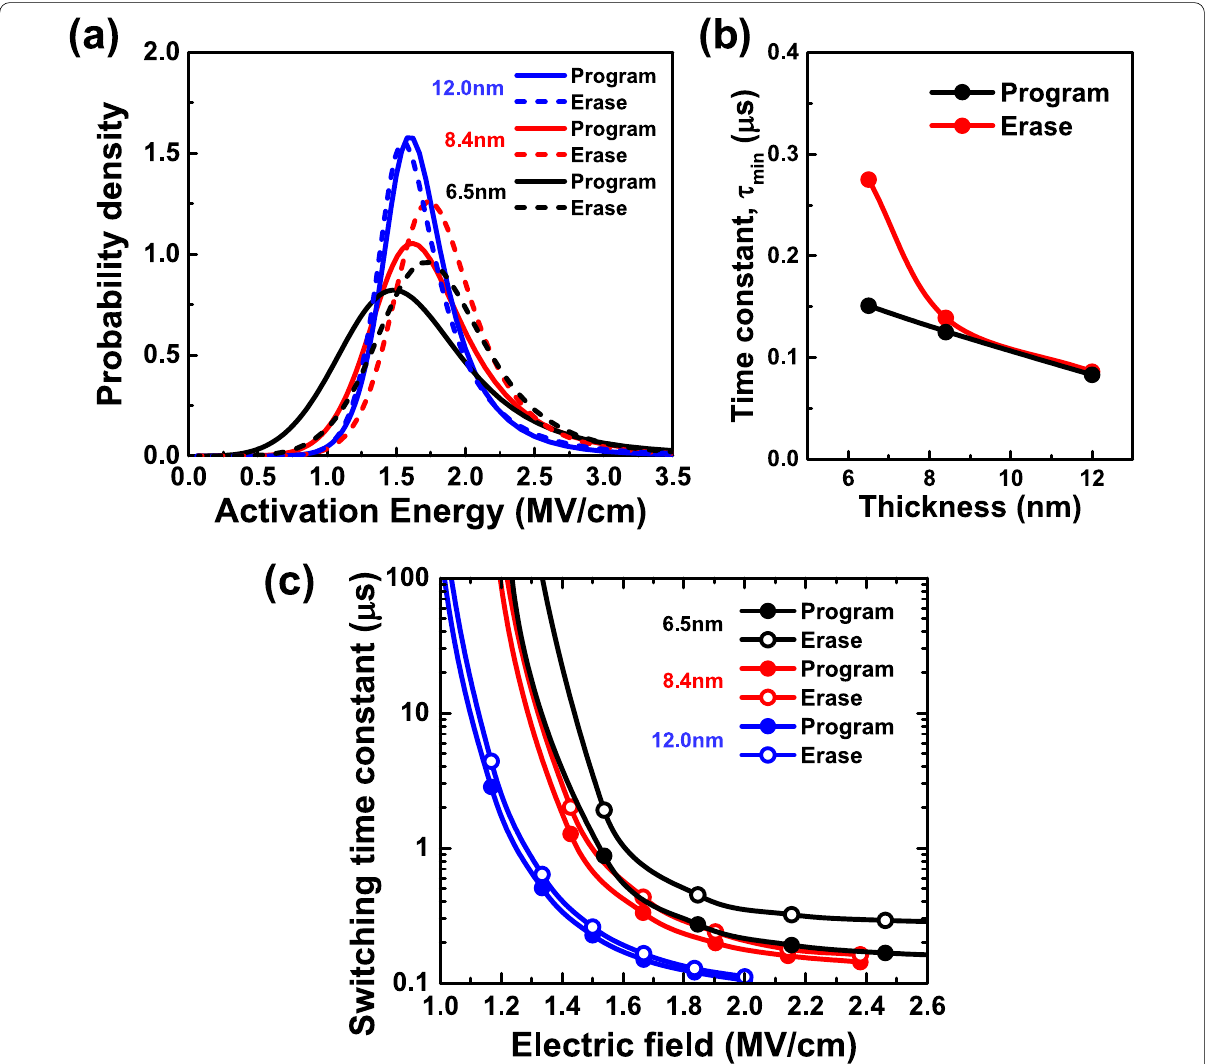
Fig. 6 Extracted ( a ) E a ’ distribution and ( b ) τ min for program and erase operation, for different HZO thickness, ( c ) calculated average time constants < τ > versus E FE for program and erase operation, for different HZO